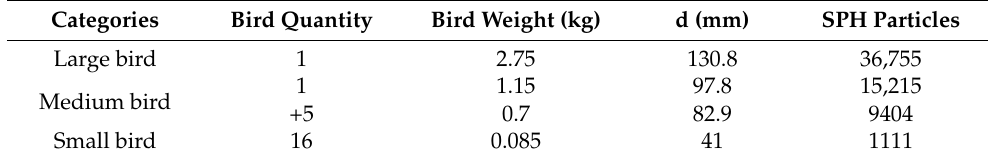
Table 1. Bird categories and